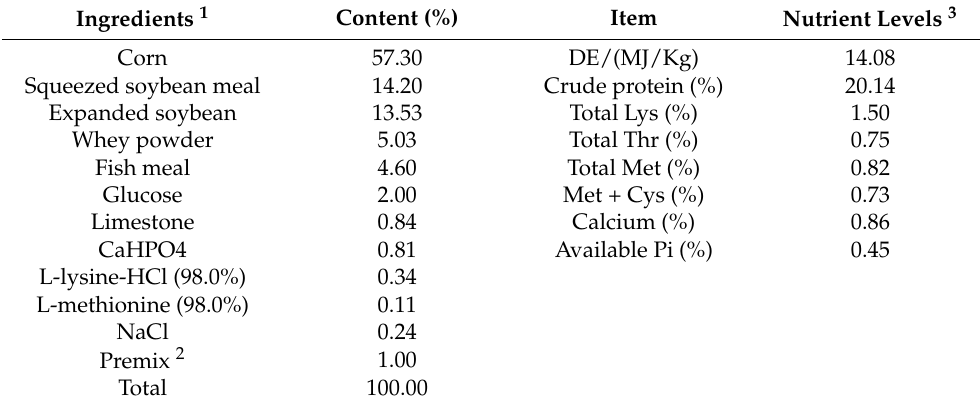
Table 1. Composition and nutrient levels of the basal